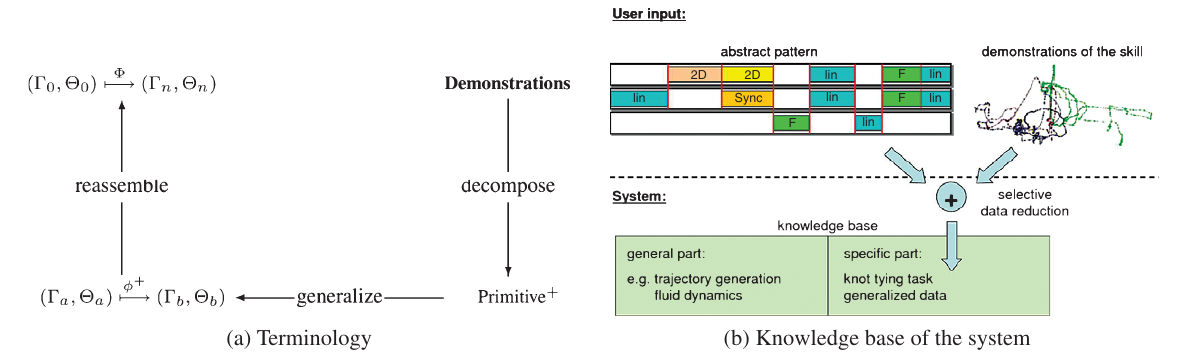
Fig. 3. (a) Summarizes the methodology of our scaffolding framework, while (b) depicts the system knowledge base.